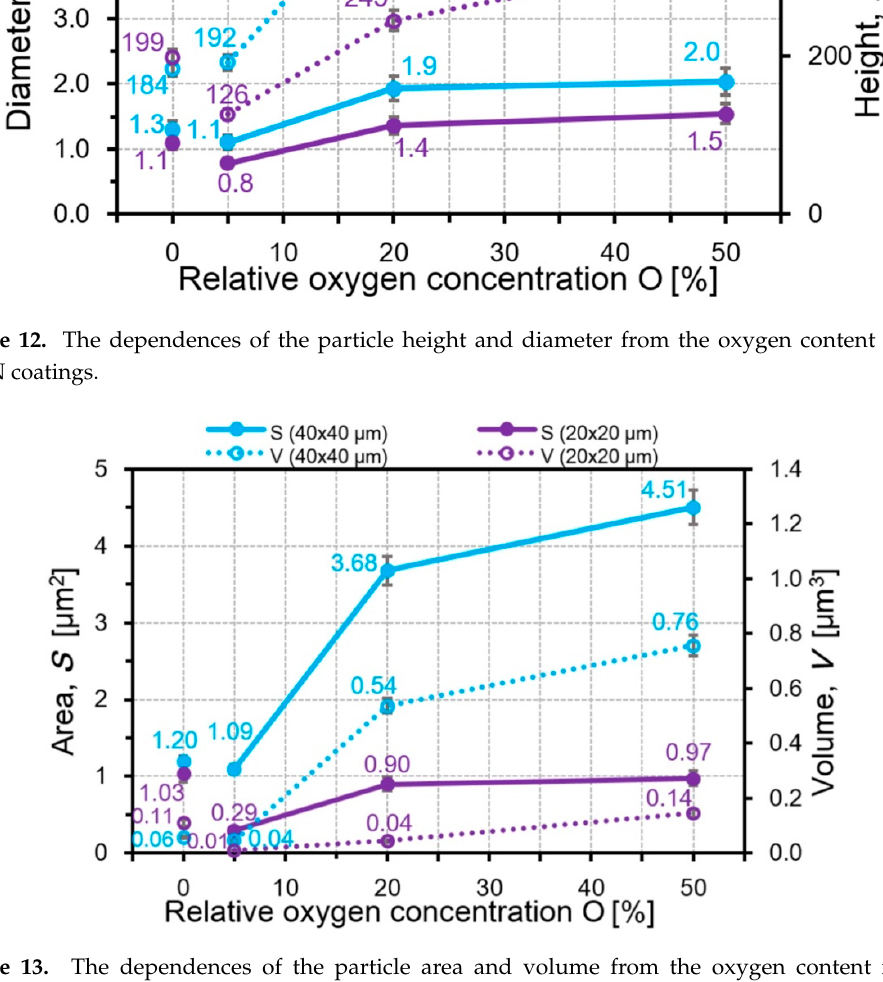
Figure 13. The dependences of the particle area and volume from the oxygen content in the CrON coatings.